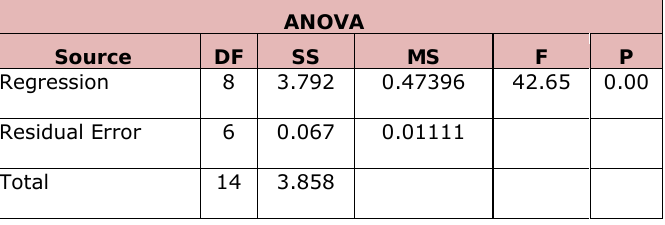
Table 3. “Analysis of Variance for Regression